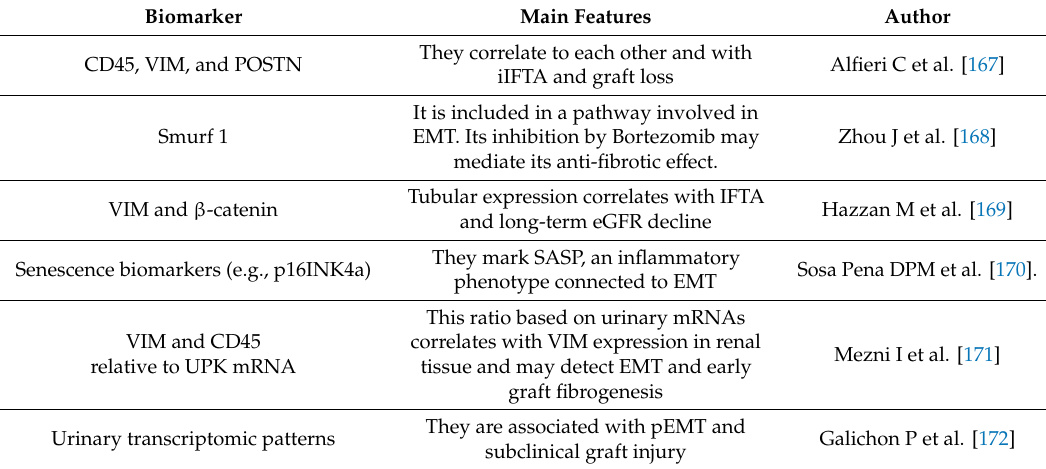
Table 8. Potential biomarkers for epithelial-to-mesenchymal transition